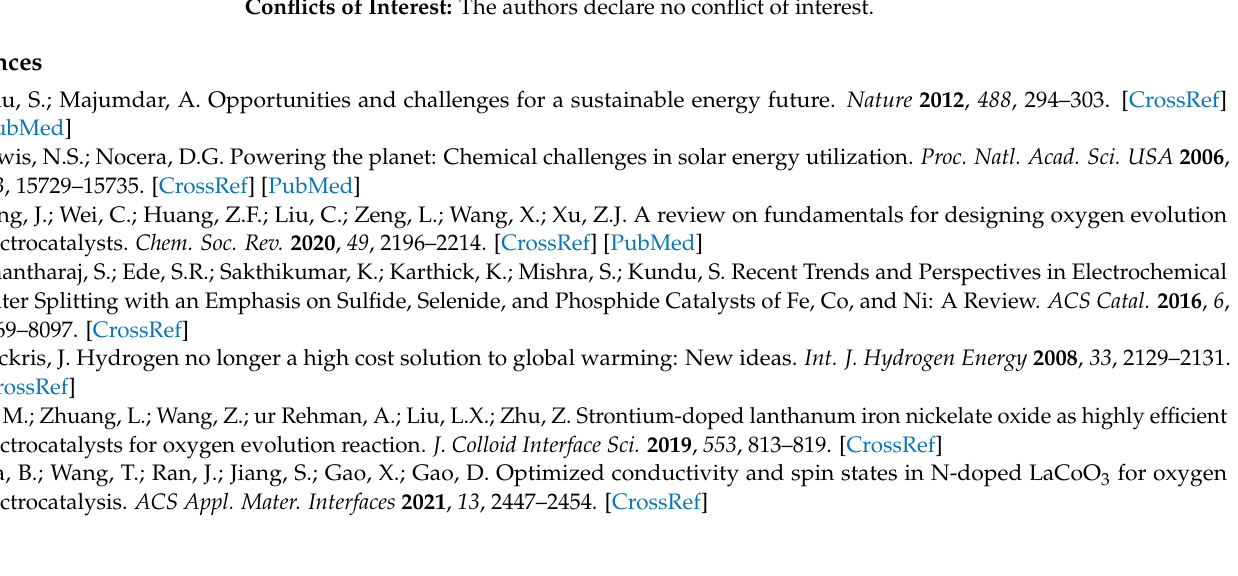
amperometry test of Sr 0.5 Ba 0.5 Co 0.95 Mn 0.05 O 3 − x also demonstrated 8.9% decay for OER